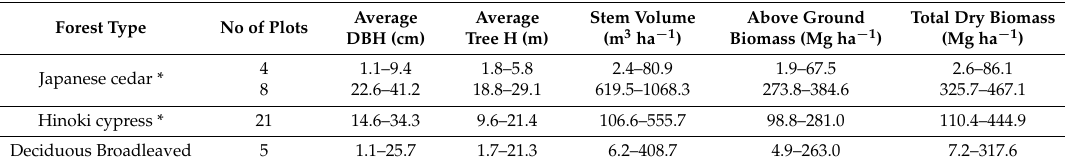
Table 1. Summary of sample plot surveys.